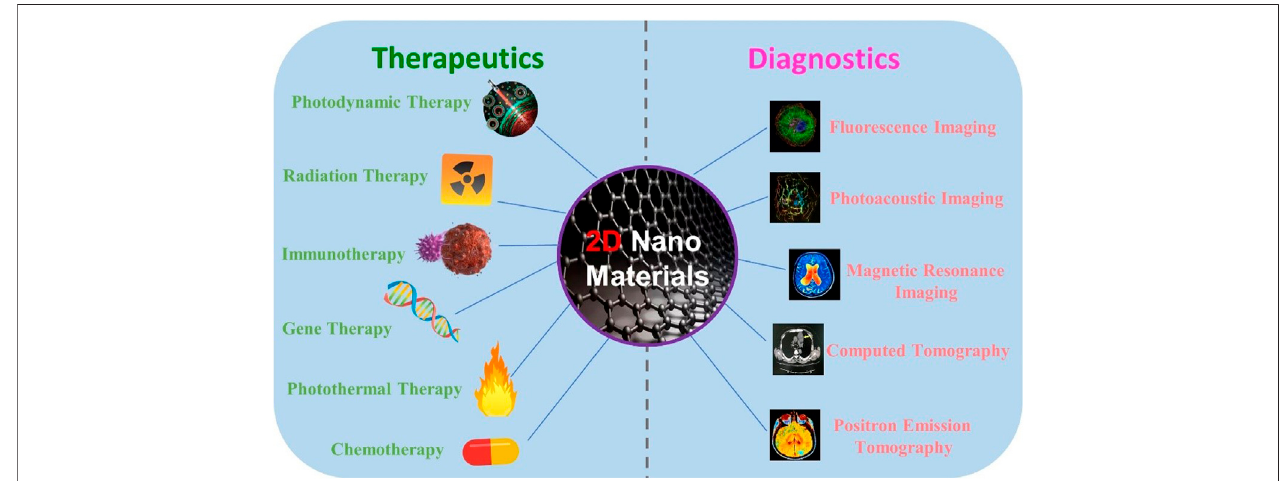
FIGURE 1 | Treatment and diagnosis methods based on the combined 2D nanomaterials. Some elements are adapted with permissions from Wang et al. (2018), copyright 2018 Ivyspring International Publisher.